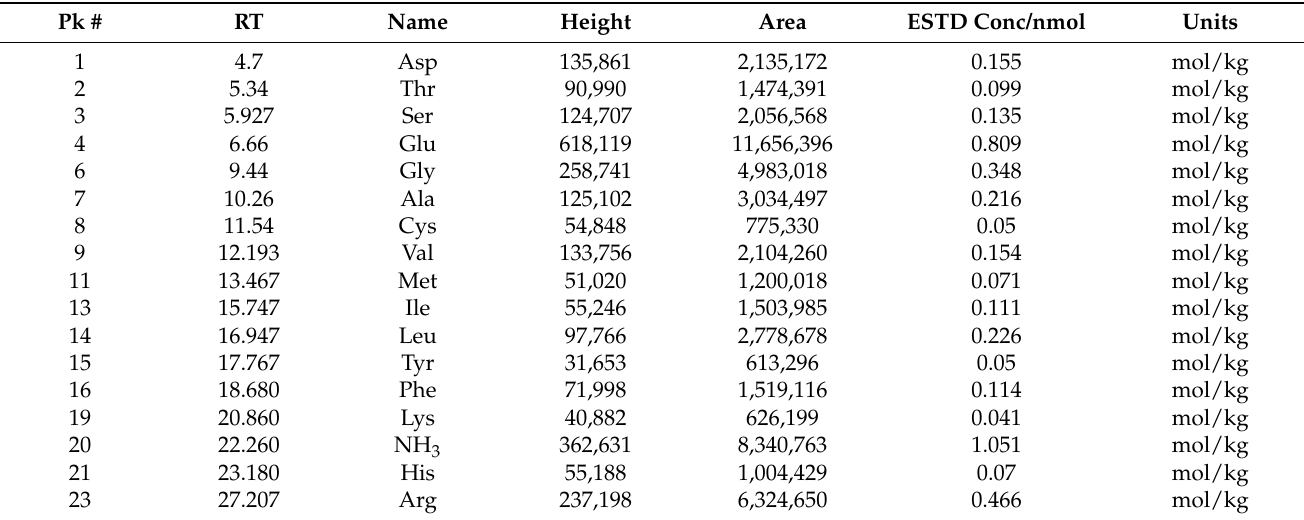
Table 1. Amino Acid Analysisof